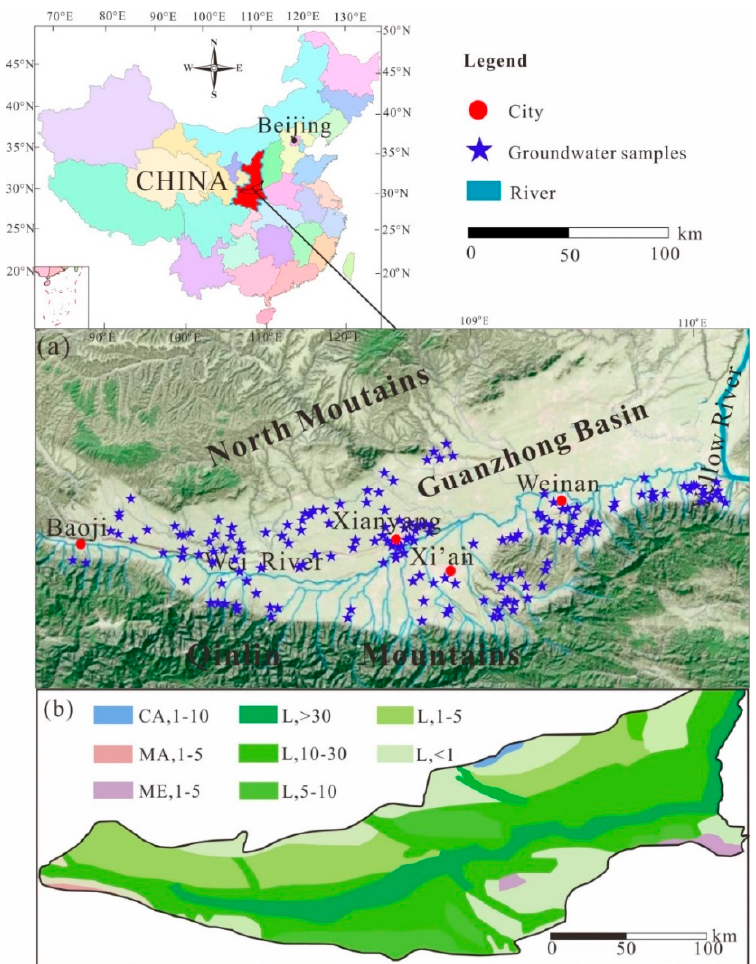
Figure 1. Study area showing ( a ) geographical locations of sampling sites and ( b ) the geological map. Fissure-karst water-bearing formations: CA, carbonate; MA, magmatic; ME, metamorphic; L, loose porous sediment. The number after the letter represents the mass specific storage (t/h*m).